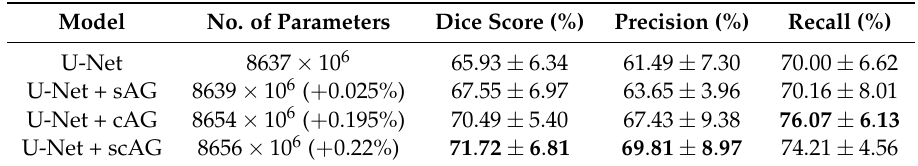
Table 6. Performance on the CVC-ClinicDB dataset by using separate attention gates (best results marked